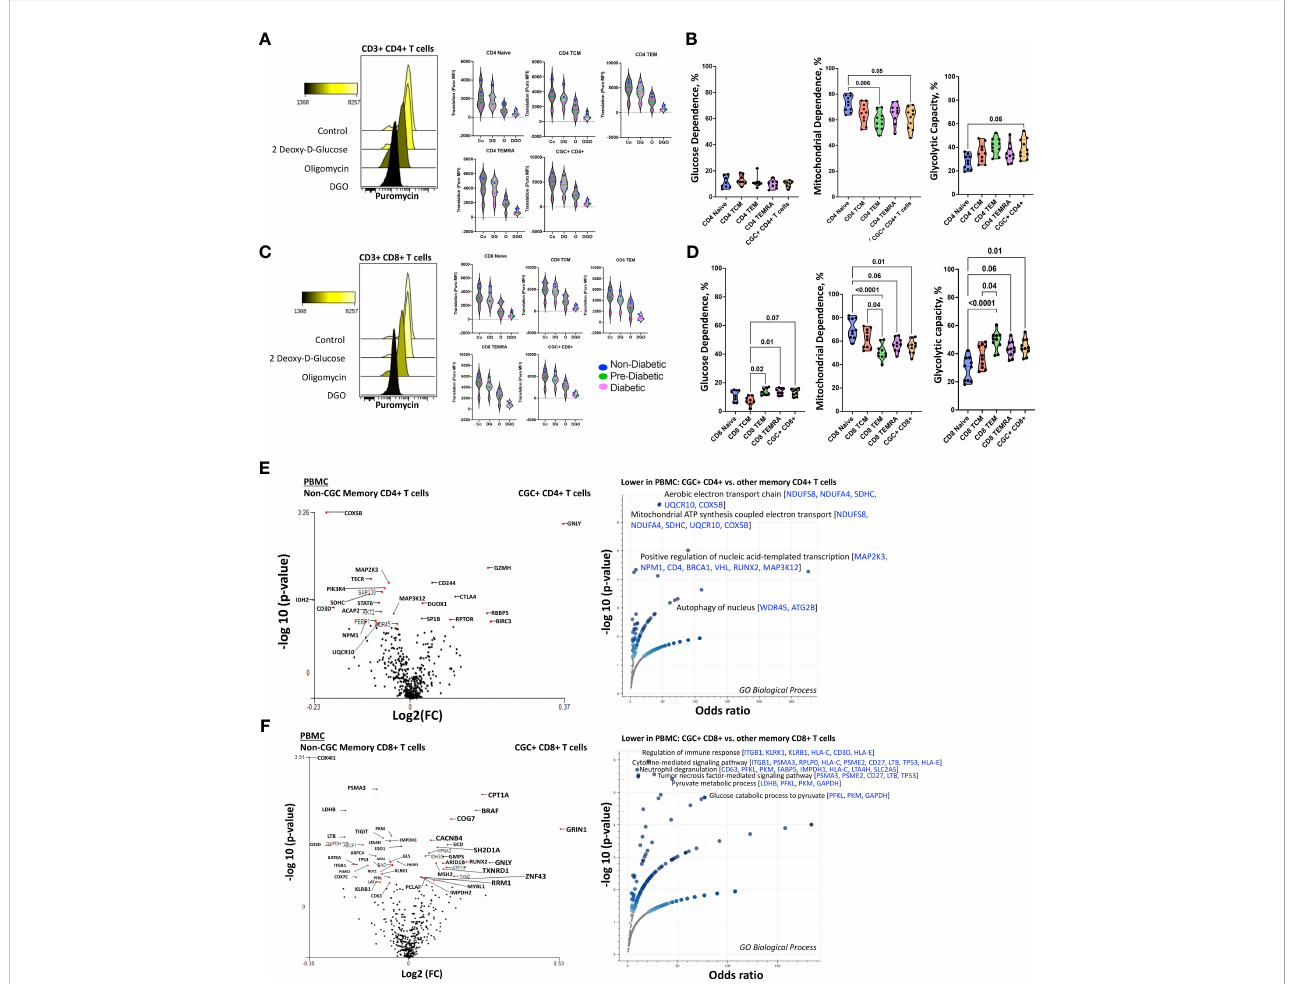
FIGURE 11 Unstimulated CGC + CD4 + and CGC + CD8 + T cells are dependent on oxidative phosphorylation. Overlapping histograms showing puromycin geometric mean fl uorescence in CD4 + T cells after treatment with 2 deoxy-d-glucose (2DG), oligomycin (o), 2DG, and oligomycin (DGO), and media (Co). Adjacent violin plots show the geometric mean fl uorescence (MFI) of puromycin in different memory subsets for the different experimental conditions (Co, DG, O, and DGO groups), and participants by color-coded by diabetes status (A) . Truncated violin plots showing the glucose dependence, mitochondrial dependence, and glycolytic capacity in all memory subsets including CGC + CD4 + T cells (B) . Similar analyses were done with CD8 + T cells showing differences in puromycin uptake in all memory subsets (C) and differences in glucose dependence, mitochondrial dependence, and glycolytic capacity (D) . Volcano plots show differential gene expression of metabolic genes between CGC + CD4 + and non-CGC CD4 + T cells (E) , and CGC + CD8 + and non- CGC + CD8 + T cells (F) . Statistical analysis (B, D) was performed using the Mann-Whitney U test and differential gene expression by the Kruskal-Wallis test. GO Biological Processes (GO) enrichment was performed using Enrichr with multiple comparisons correction (Supplemental Tables S5, S7) (38 –